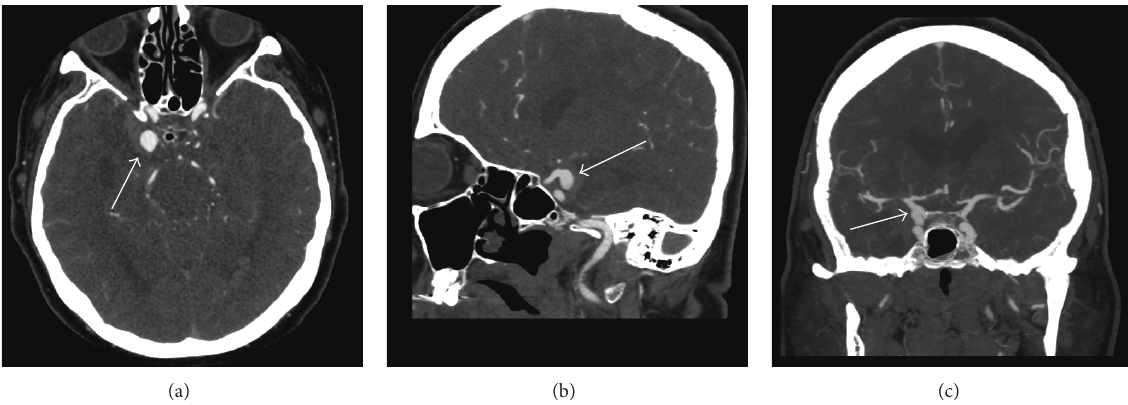
Figure 1: Preoperative CT-Angiogram. CT: computed tomography, CTA: computed tomographic angiography, PComm: posterior communicating artery. (a) Axial CTA displaying right PComm aneurysm (white arrow). (b) Sagittal CTA image displaying right PComm aneurysm arising from supraclinoid internal carotid artery (white arrow). (c) Coronal CTA image displaying the right PComm aneurysm (white